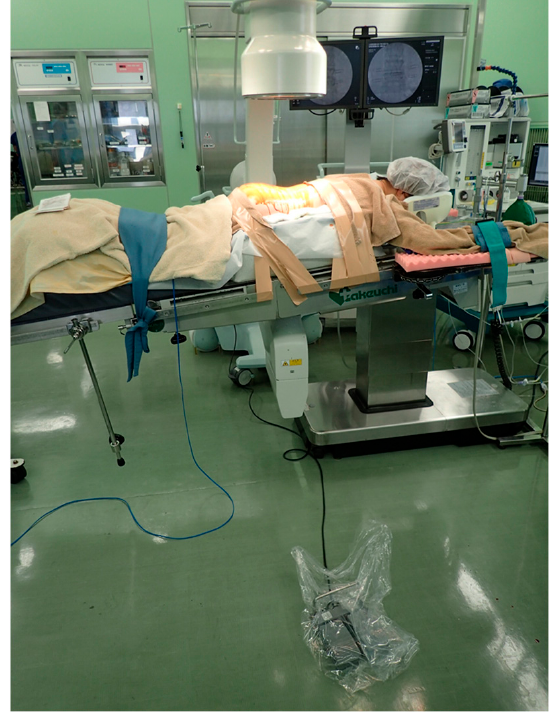
Figure 1. Operating room setup (the foot switch is at least 1 m away from the operating table). A disposable needle was adjusted semi-blindly to avoid direct radiation exposure.